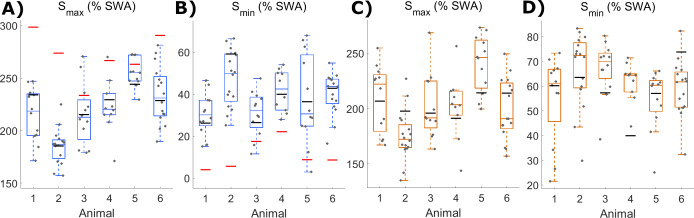
Values for Smax and Smin parameters in Process S models derived from SWA.(A) The distribution of values estimated for Smax and (B) Smin parameters in Process S models derived from SWA with the classic model and (C-D) with the firing-rate-based model, with boxplots plotted separately for each animal. The black lines indicate the values obtained from modelling the averaged LFP SWA and firing rate over all channels within an animal. Additionally, the red lines (in A and B only) give the parameter value obtained from the model of the frontal EEG SWA of the corresponding animal.